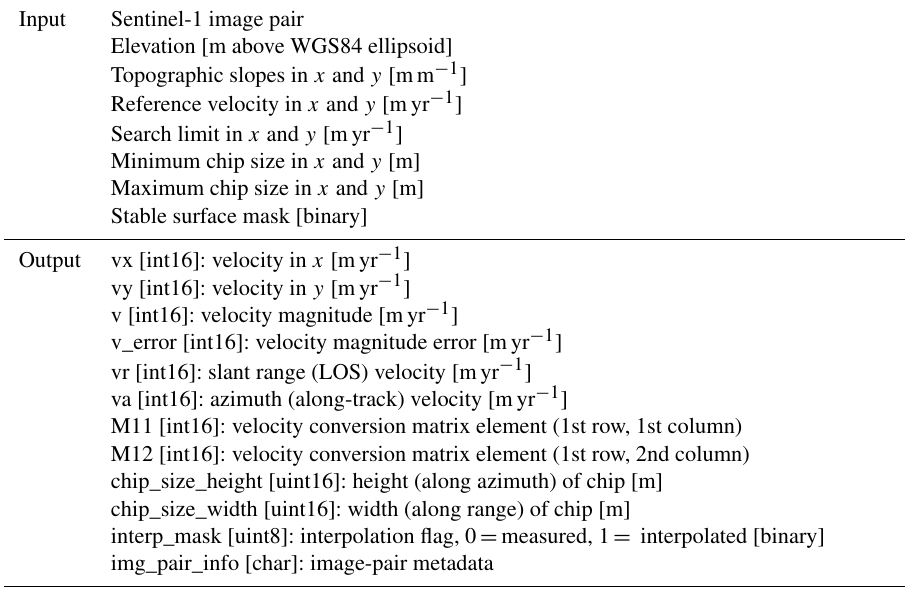
Table 2. Input and output data for the MEaSUREs ITS_LIVE Sentinel-1 Image-Pair Glacier and Ice Sheet Surface Velocities: Version 2 processing chain, x and y are directions in map coordinates. Each output variable is accompanied by variable specific